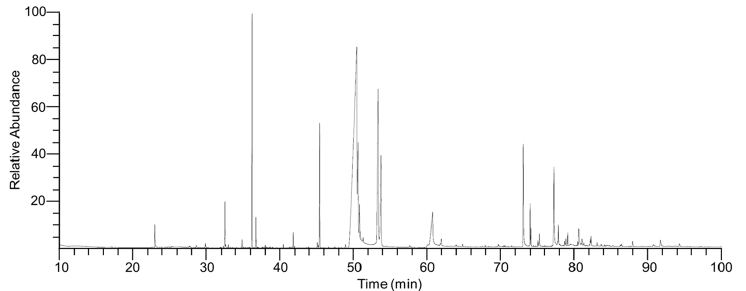
Figure 1. GC/MS total ion chromatogram of Impatiens textori Miq. flower absolute. Peaks represent the 40 identified compounds listed in Table 1. Table 1. Components of Impatiens textori Miq. flower absolute.